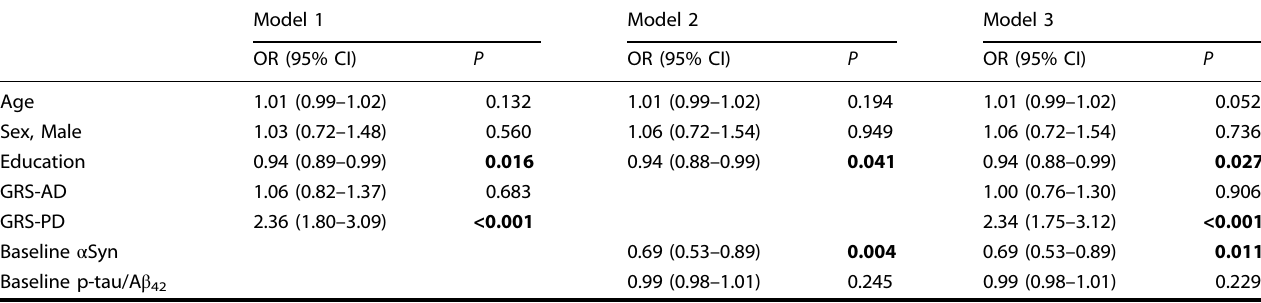
Table 2. Effect of CSF biomarkers and genetic risk scores on the diagnosis of PD.